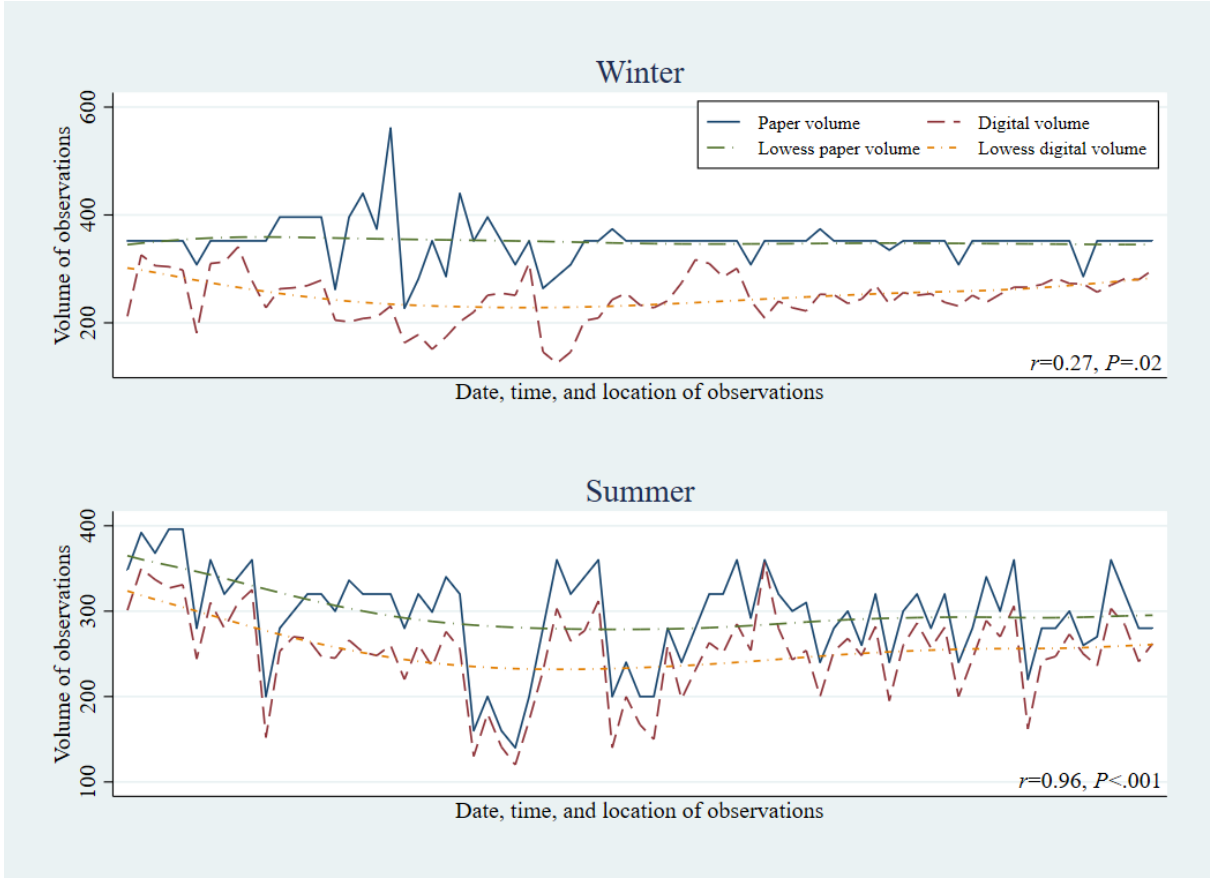
Figure 1. Correct helmet use: correlation between digital and paper volumes of observations by